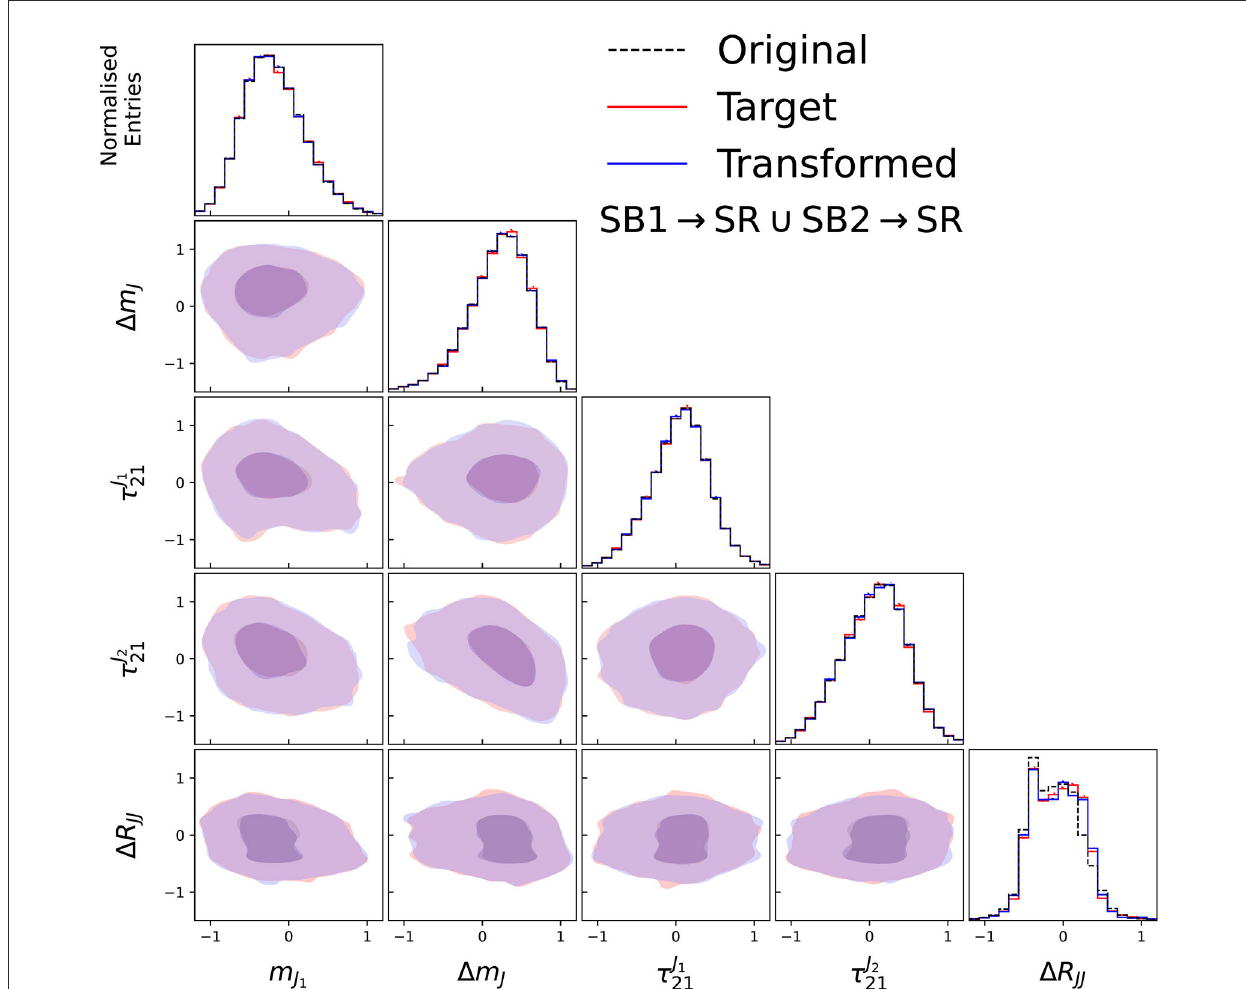
FIGURE5 Input, target, and transformed data distributions for the base variable set with the addition of 1 R JJ , for transforming data from SB1 and SB2 to the signal region to create the background template, with the model trained on SB1 (3,200 data from SB1 (SB2) is transformed with a forward (inverse) pass of the C URTAIN s model into the target region. The diagonal elements show the individual features with the off diagonal elements showing a contour plot between the two observables for the transformed and trained data.